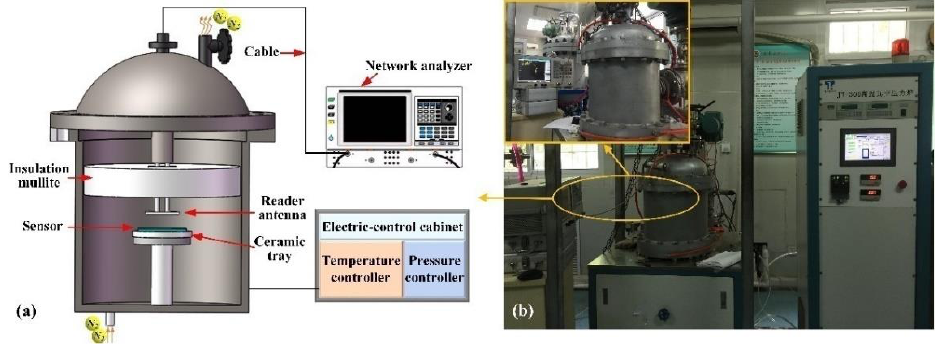
Figure 5. Temperature–pressure composite measurement platform. ( a ) Working principle of pressure measurement system. ( b ) High-temperature pressure experimental platform.